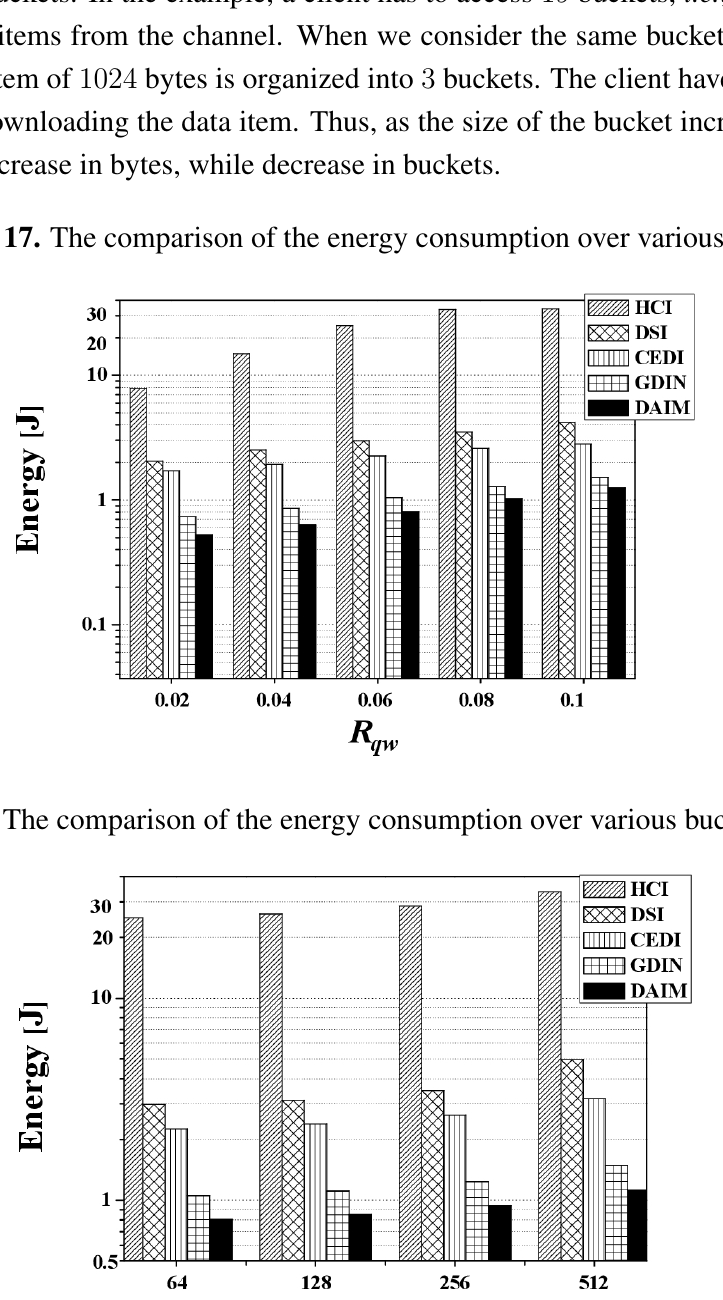
Figure 17. The comparison of the energy consumption over various R